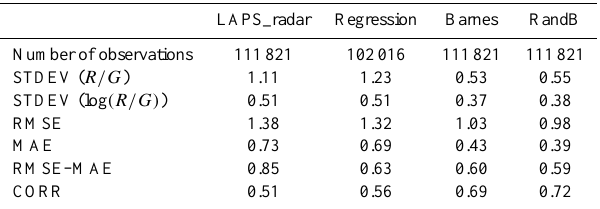
Table 1. Statistical verification results of the different methods for the dependent stations data